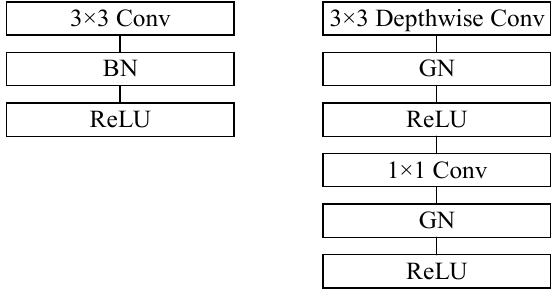
Figure 4. MobileNet Model proposed in our algorithm. Left : Standard convolutional layer with batch normalization and ReLU (Rectified Linear Units). Right : Proposed convolutional layer with group normalization and ReLU.